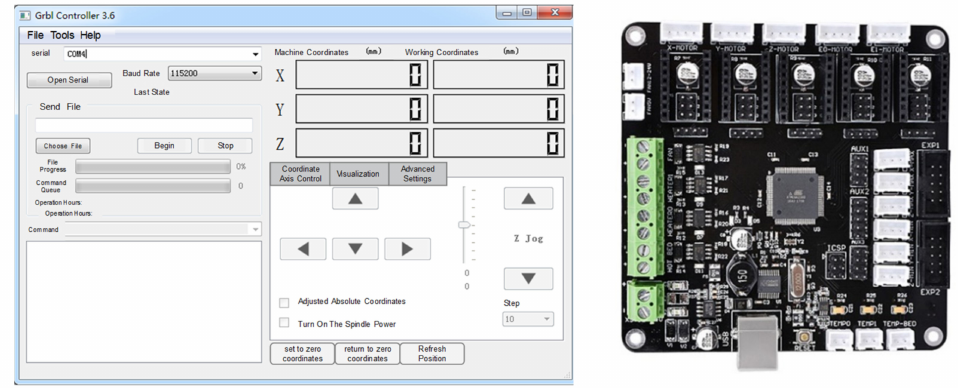
Figure 3. The interface of the 3D motion-control software, and the circuit board of the